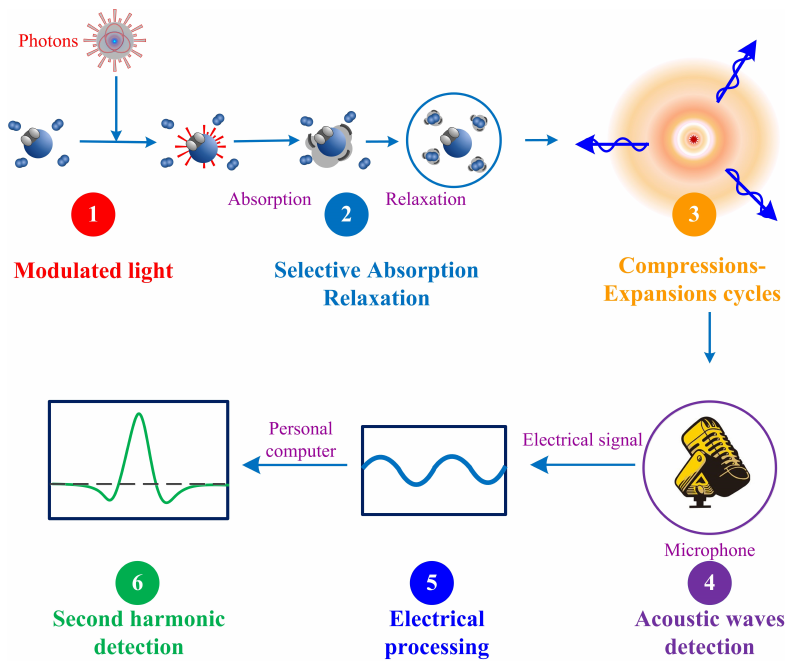
Figure 1. The principle of the PAS